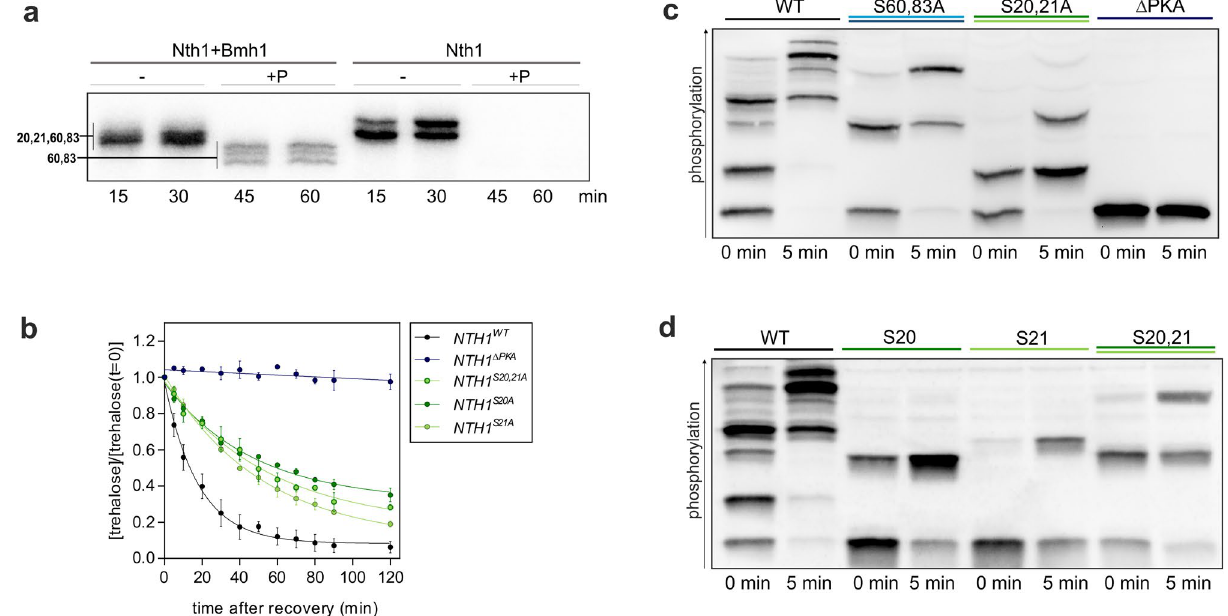
Figure 6. The PKA sites S20 and S21 are required for full activation. ( a ) Autoradiograph after Phos-tag SDS- PAGE of an in vitro shielding assay of recombinant 6x-His tagged Bmh1 and full-length 6x-His-tagged Nth1. Nth1 was phosphorylated by PKA in presence or absence of Bmh1 (5:1, Bmh1:Nth1). At the 30 min time point PKA inhibitor and lambda phosphatase were added. See Supplementary Figs. S3a,b for Coomassie and mass spectrometry analysis, respectively. ( b ) Normalized trehalose concentration of cells recovered from stationary phase by dilution in 1% GMM. SEM for three biological replicates with two technical replicates each. All trehalose concentrations were normalized to the concentration at t = 0 min. See Supplementary Table S3 for absolute concentrations. ( c ) and ( d ) Phos-tag SDS-PAGE of cells expressing 3x-FLAG-tagged Nth1-reporter constructs recovered from stationary